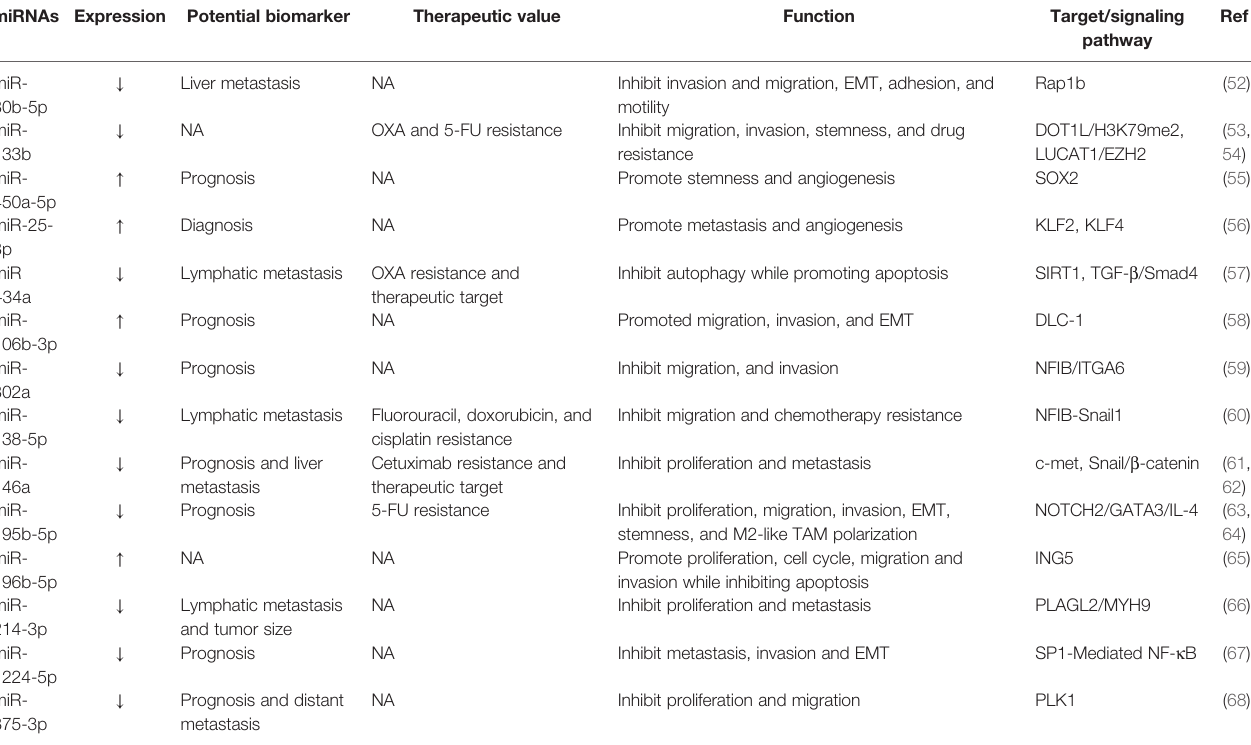
TABLE 2 | Selected examples of regulatory miRNAs. miRNAs Expression Potential